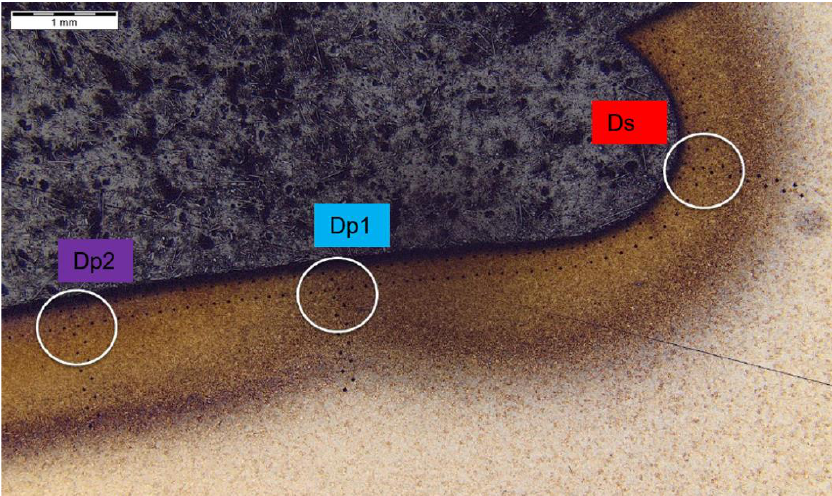
Figure 23. Waviness of carburized case depth. Reduction in carburized case depth within the area Dp1. Magnification: 12.5×. Cross-section H-H. Etched sample — Nital 5%.